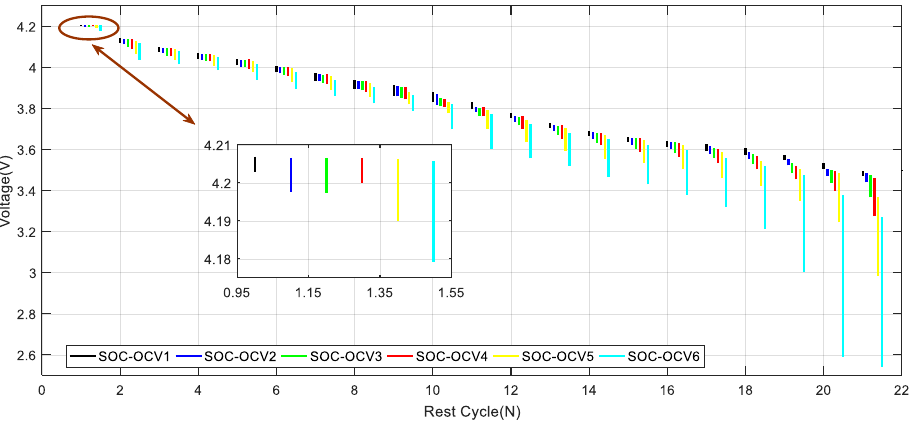
Figure 5. Terminal voltage drop after it rests for two hours.